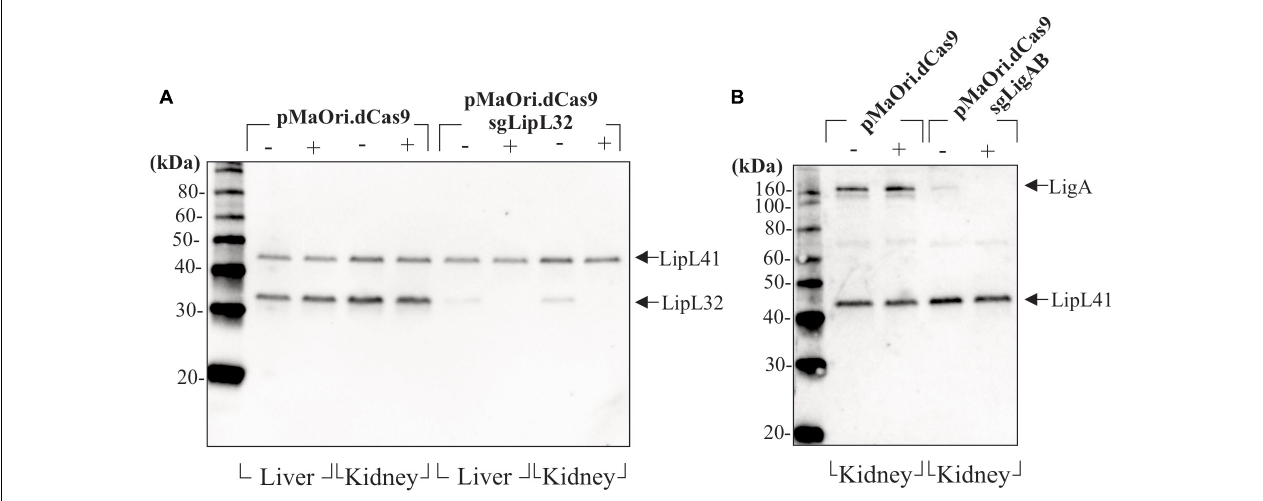
FIGURE 6 | Evaluation of gene-silencing stability after mutants’ recovery. Liver and kidneys from animals sampled after reaching endpoints or at the end of the experiment (chronic infection) were macerated and inoculated in HAN media plus 5-FU in the absence ( − ) or presence ( + ) of spectinomycin for selectively allowing mutant growth. Cells recovered from animals sampled at the acute time frame (4–5 days) (A) and at the end of the experiment (B) were evaluated by